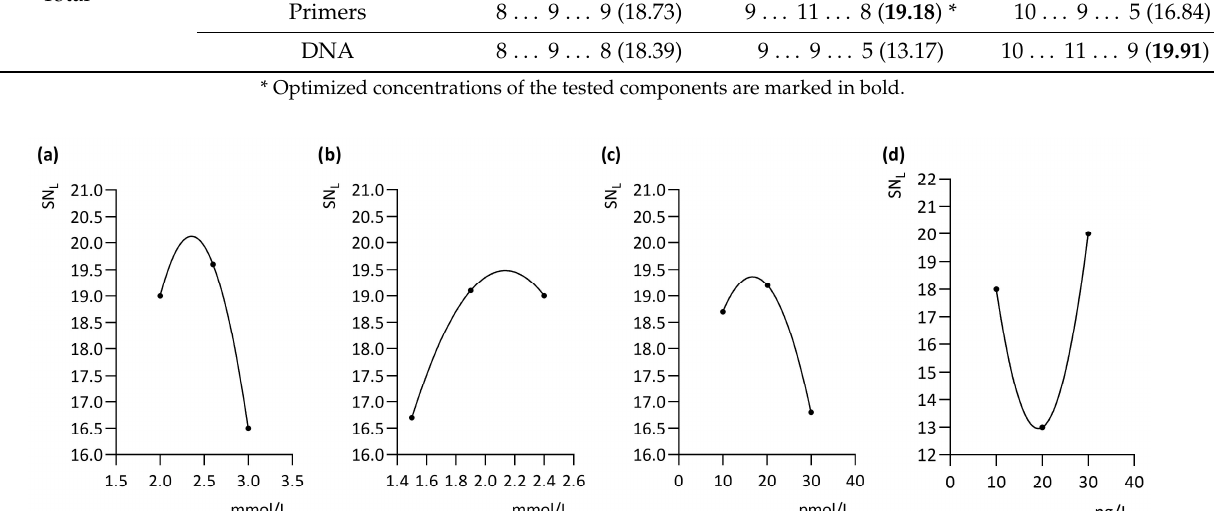
Figure 2. Results of particular components ( a —MgCl 2 , b —dNTPs, c —RP2 and 1247 primers, d —DNA) on the signal-to-noise ratio (SN L ) for RAPD-PCR fingerprinting and RP2 and 1247 pri- mers.